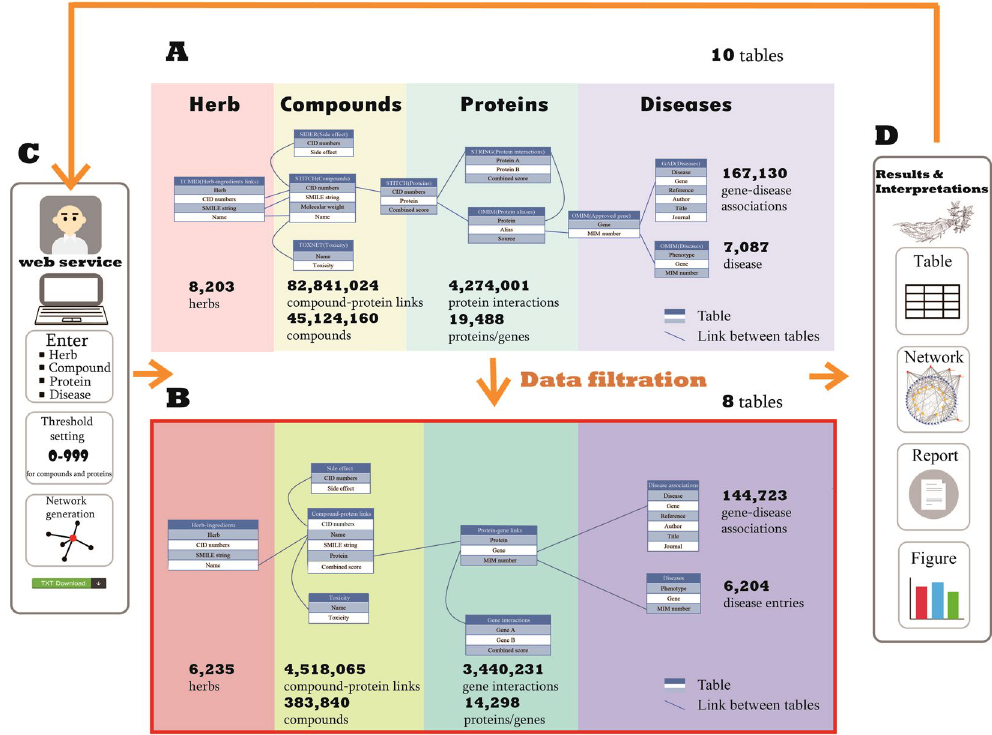
Figure 7. The data organization scheme and search pipeline of TCM-Mesh. ( A ) the source data of the TCM- Mesh, the raw data was consisted of ten data fields; ( B ) the filtered data of the TCM-Mesh, the filtered data consisted of eight data fields, and the size of data was reduced significantly compared with the previous database shown in ( A) ; ( C ) the web service provided for TCM-Mesh, compound, protein, gene and disease could be input for searching, threshold of combined score could be set by users to filter the results, network and download functions were available; ( D ) the results and interpretation showed by TCM-Mesh, which could be use for further analysis. The ginseng in the figure was drawn in-house according to the real